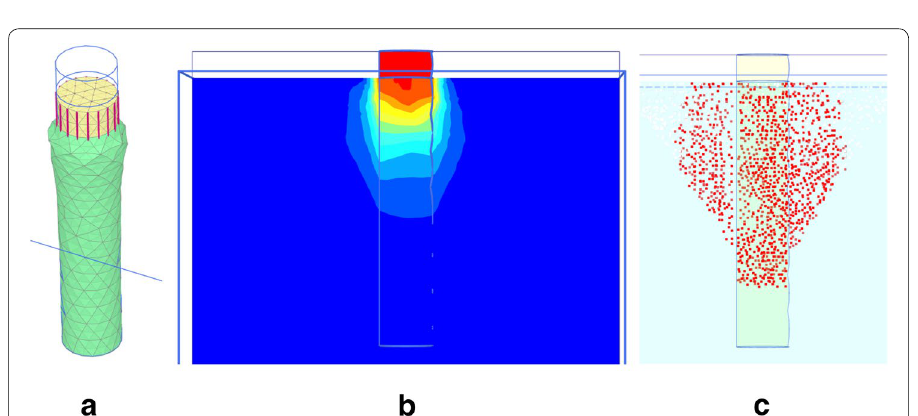
Fig. 4 Column with C u column; c plastic